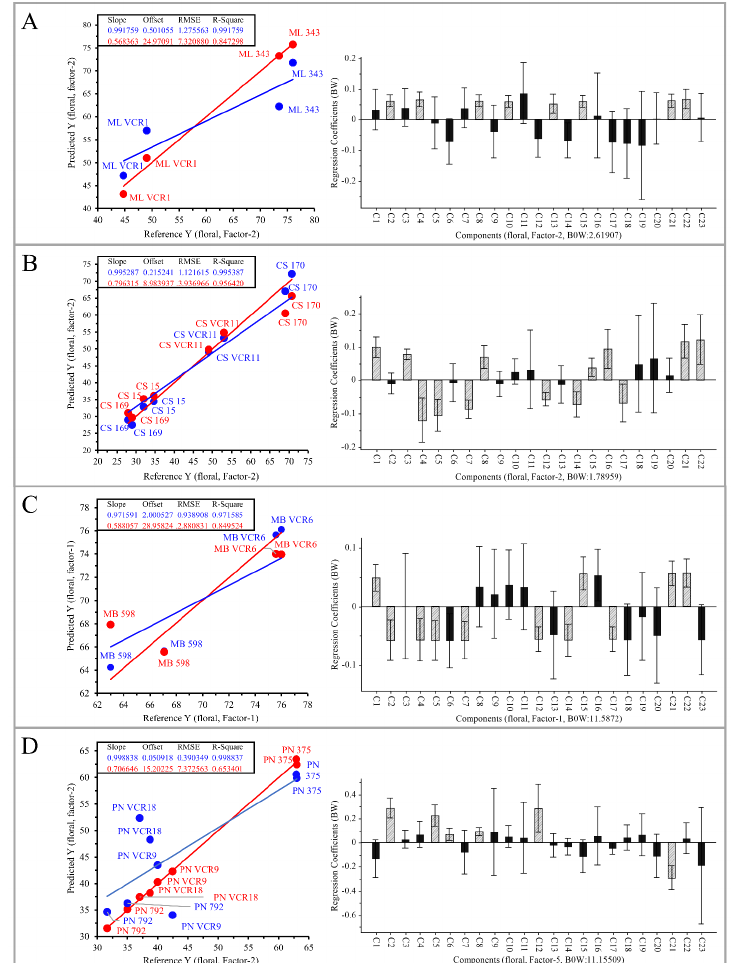
Figure 4. The PLSR analysis of floral sensory and volatile compounds, standardized and estimated regression coefficients from the PLSR model showed a significant correlation between volatile com- pounds and floral sensory odor attributes in Merlot ( A ), Cabernet Sauvignon ( B ), Malbec ( C ), and Pinot Noir ( D ) wine samples. Bar with slash indicates a significant effect ( p <